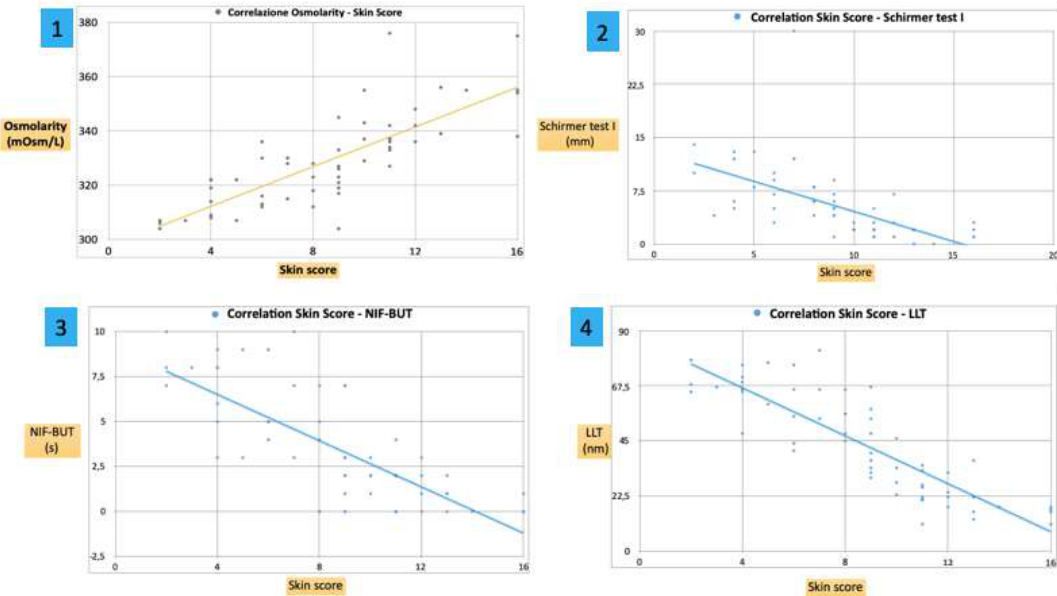
Figure 4. Graph 1: a positive correlation was found between osmolarity (Osmol / L) and the skin score (r = 0.79; p < 0.001), showing a marked increase in the subjects with a more serious disease. Graph 2, Graph 3 and Graph 4: a negative correlation was found between the Schirmer test I (mm), NIF-BUT (s), LLT (nm) and the skin score (r = − 0.6, r = − 0.76 and r = − 0.85 with p < 0.01, p < 0.01 and p < 0.001 respectively), showing a marked decrease in the subjects with a more serious disease.